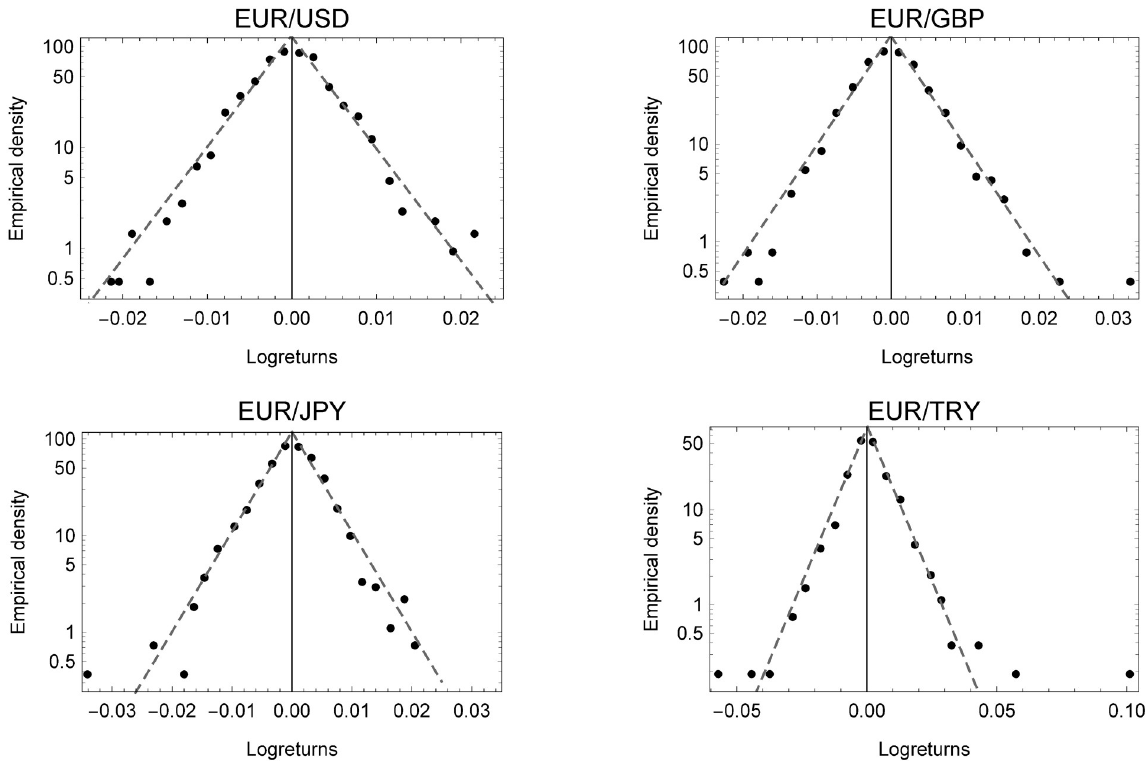
Fig 3. Empirical densities of foreign currencies. Empirical densities of foreign currency exchange rate log-returns for the currencies valued against the Euro.